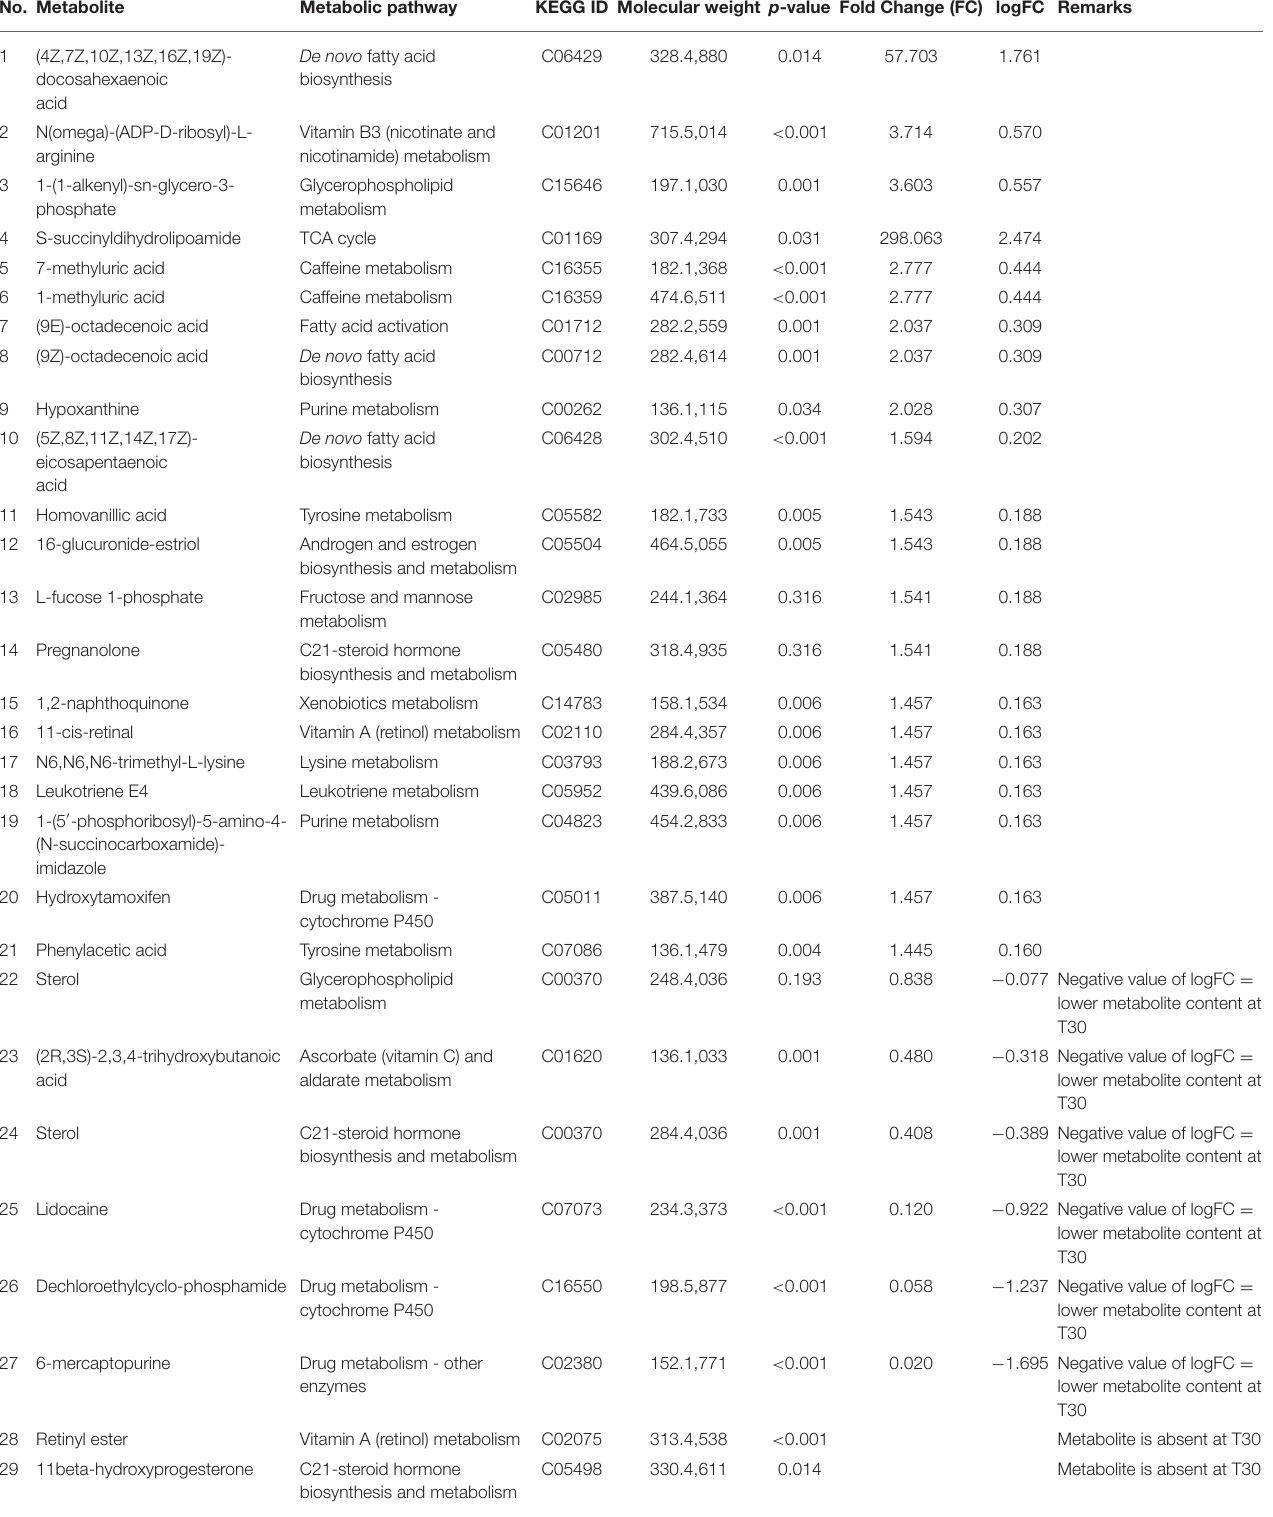
TABLE 2 | List of significantly ( p < 0.05) regulated metabolites in dog saliva after 30 days of placebo administration. No.